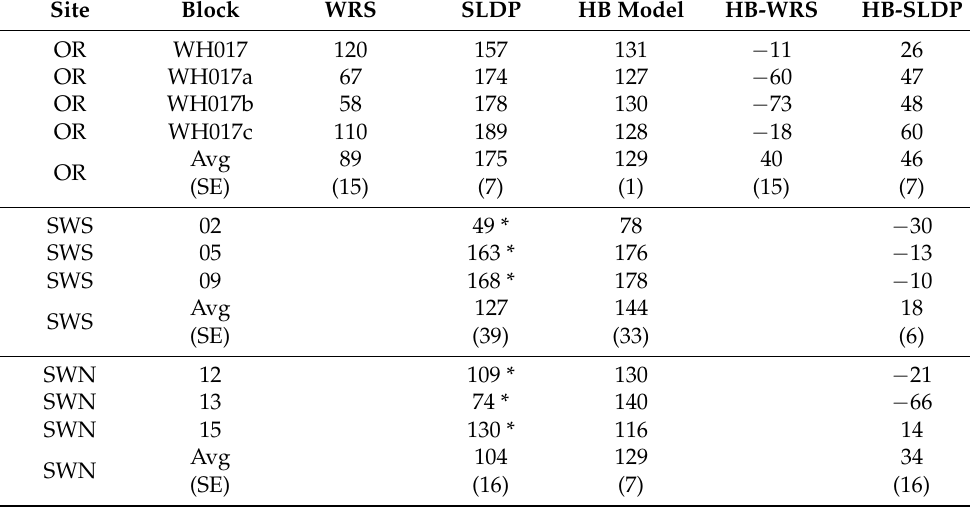
Figure 5. ( A ) Block merchantable volume (m 3 ha –1 ) absolute difference of post-harvest scale (HS) from pre-harvest forest cover (FC) (blue) and pre-harvest hybrid model (HB) (orange). ( B ) Block non-merchantable volume (m 3 ha − 1 ) absolute difference from pre-harvest hybrid model (HB) for the post-harvest semi-automated log delineation plus piles (SLDP) (blue) and the post-harvest waste and residue survey (WRS) (orange). Note: HS and SLDP values for SWS and SWN were simulated using field measurements for all trees in the block. WRS values for SWS and SWN are N/A (-1). Table 6. Block non-merchantable volumes (m 3 ha − 1 ) for the post-harvest waste and residue survey (WRS) estimate, post-harvest semi-automated log delineation plus piles (SLDP) residue estimate, pre-harvest hybrid (HB) model predictions, and differences between pre-harvest estimates and post- harvest values. Average volume differences use the average absolute difference. SE—standard error. * Note: SLDP values for SWS and SWN were simulated using field measurements for all trees in the block. All blocks n = 12 excludes values for SWS and